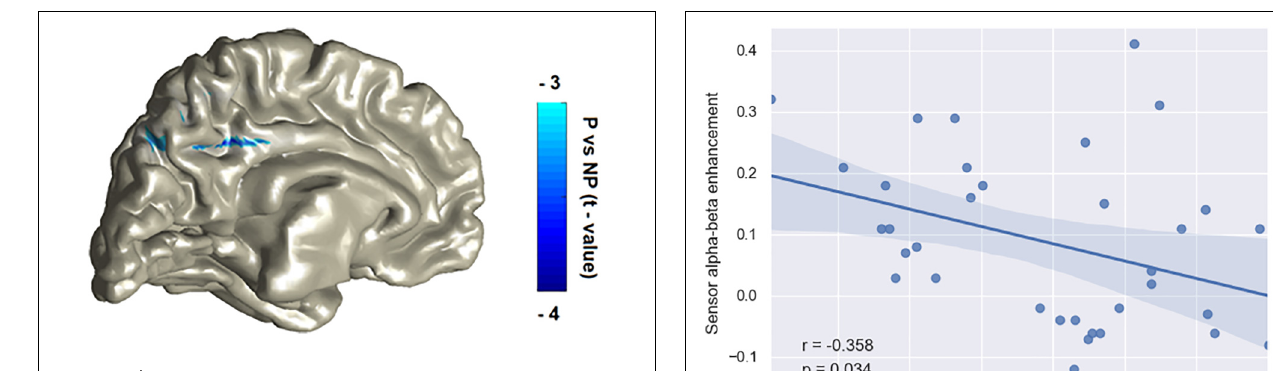
FIGURE 2 | P vs NP statistical contrast of the source localization of the beta suppression effect. The localization procedure reveals two main peaks, in the cingulate cortex and in the precuneus. The patterns were laid over on MNI template with a color bar representing masked and peak statistical activity (P cluster − cor < 0.05).